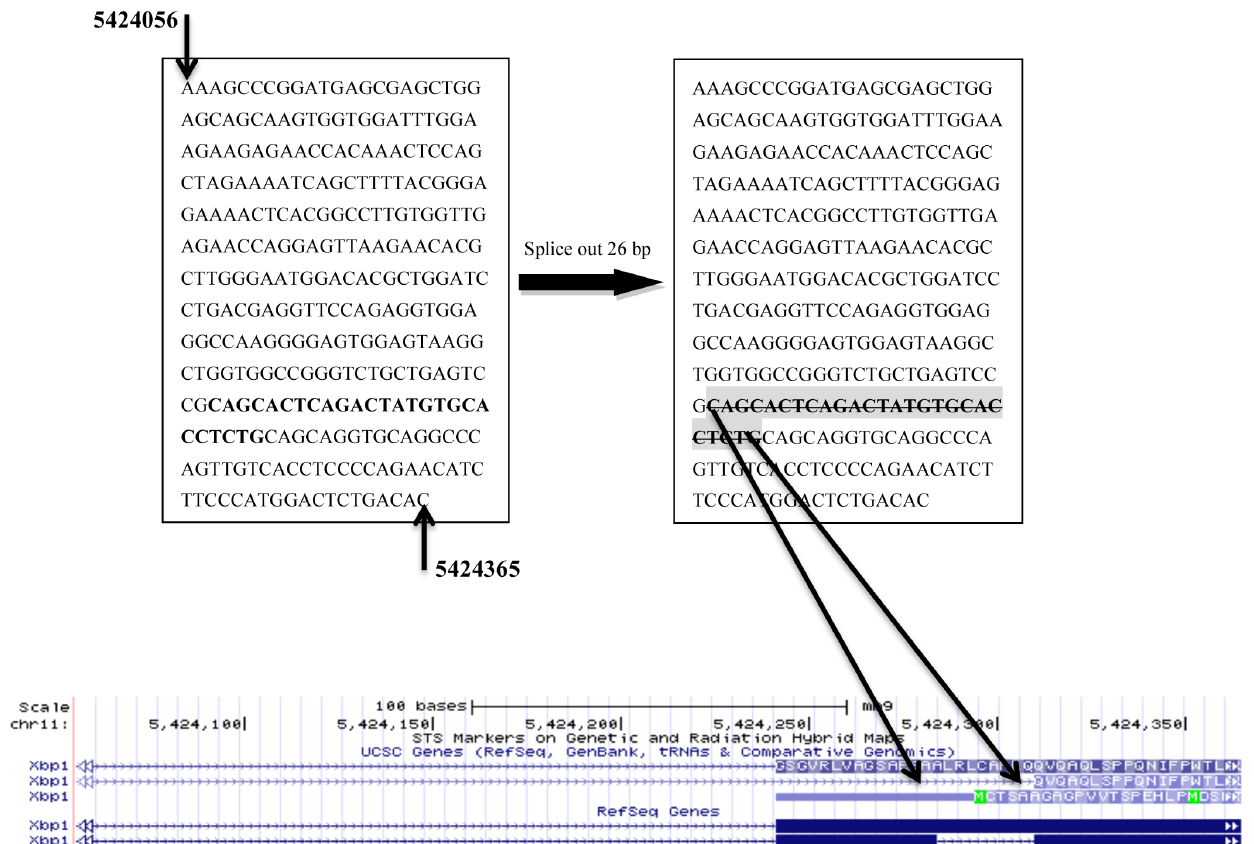
Figure 1. Xbp1 ’s partial transcript sequence, including the non-canonical 26 nt spliced region (highlighted on right).